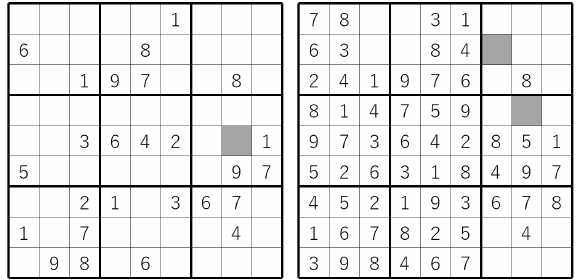
Figure 3. Starting with the partially completed grid on the ( left ), one can reach the grid on the ( right ) using only naked singles but cannot proceed any